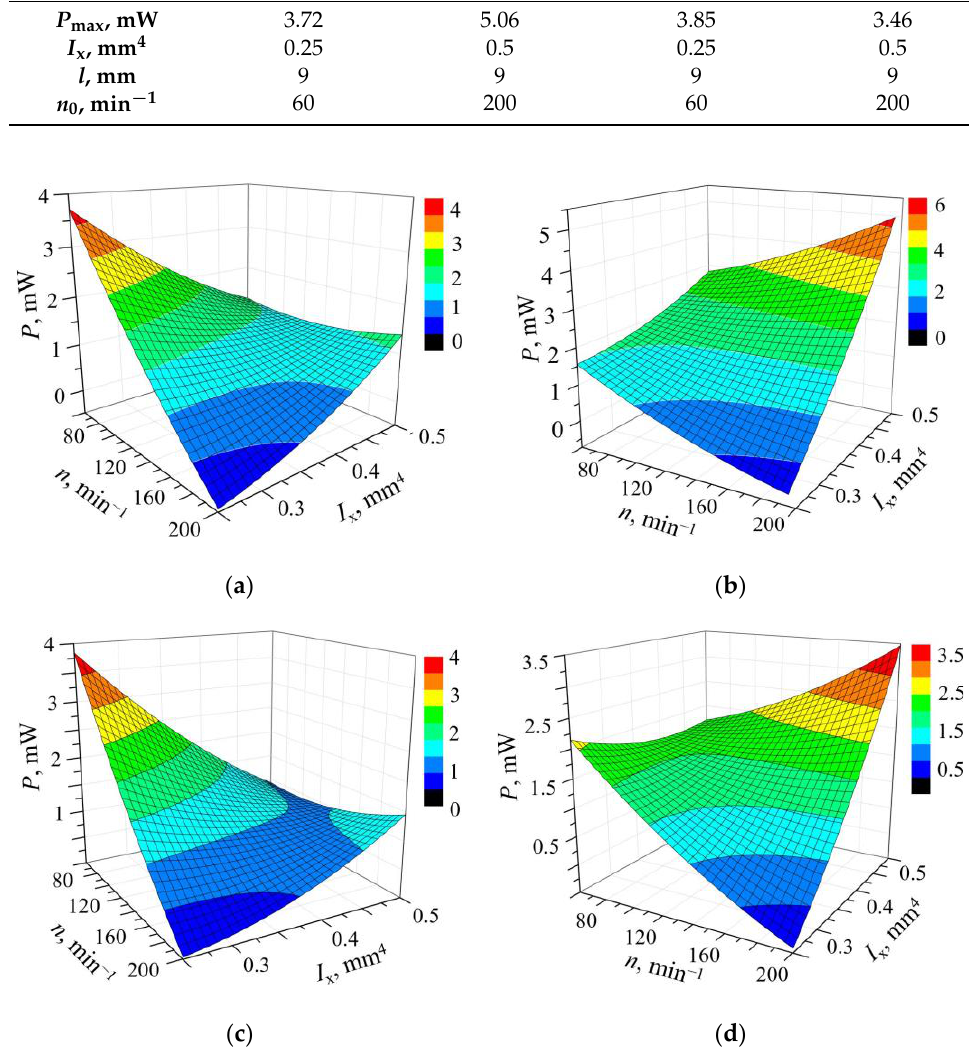
Figure 5. Power outputs resulting from the quadratic regression model for a constant plectrum length made from different materials: PA ( a ), PC ( b ), ABS ( c ) and PLA ( d ) [15]. made from different materials: PA ( a ), PC ( b ), ABS ( c ) and PLA ( d )